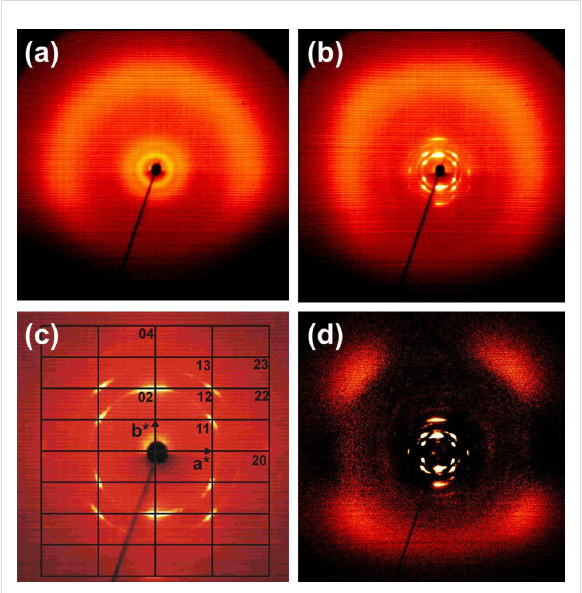
Figure 6: 2D X-ray patterns for 1a: (a) isotropic liquid at 150 °C, (b) columnar mesophase at 100 °C, surface aligned on cooling, (c) small angle region at 100 °C with reciprocal axes and indices for the 2D lattice of the columnar phase, (d) scattering at 150 °C subtracted from that at 100 °C to enhance the effect of the anisotropic distribution of the diffuse scattering.